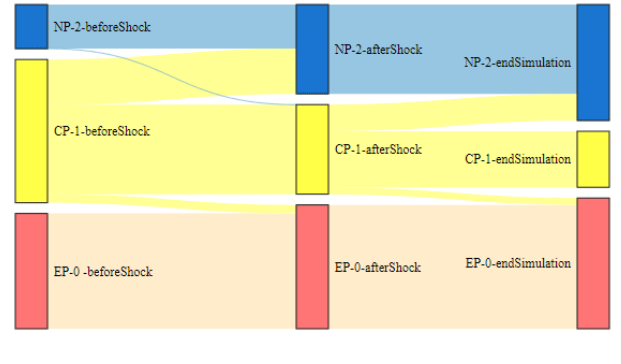
Fig. 3 . Households’ livelihood state at the sampled time slots (baseline). The bottom is the extremely poor (EP-0) state, the middle panel is the chronic poor (CP-1), and the top section is the nonpoor (NP-2). The left panel is the before shock time slot, middle panel is the after shock point, and the right panel is the end of simulation slot. All households from EP-0 before shock stayed as EP-0 over the simulation and ended up at EP-0 at the end of simulation. All households from NP-2 before shock stayed as NP-2 over simulation. Some CP-1 households before shock joined the NP-2 at the end, and there was a small group of CP-1 before shock that ended up at the EP-0 at the end of simulation.